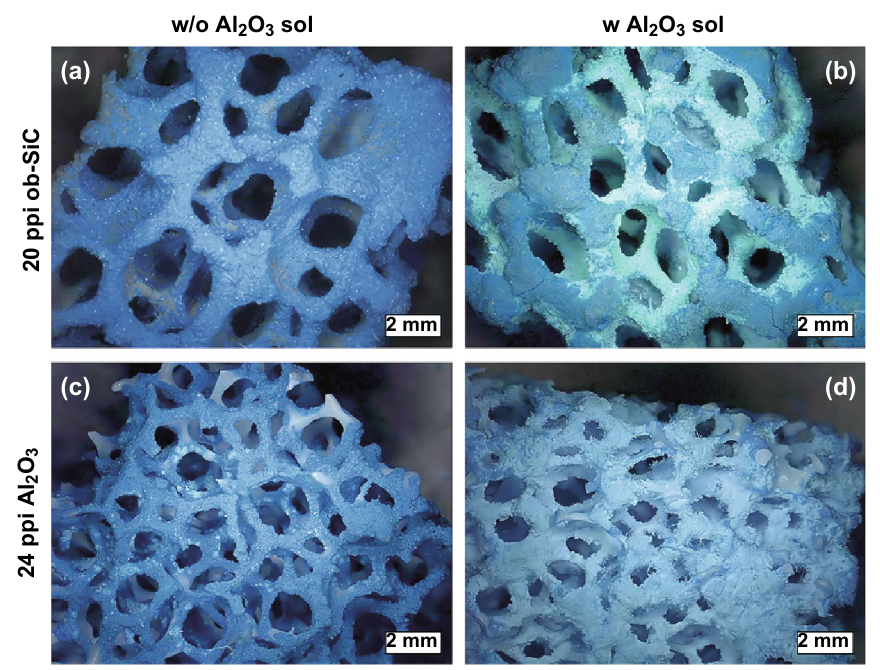
Fig. 3 SEM images of HKUST-1 coatings on ob-SiC and Al 2 O 3 ceramic foams a, c without and b, d with preliminary alumina sol coating. The HKUST-1 coating layers on the ob-SiC composites are thicker than those on Al 2 O 3 composites. Reprinted with permission from Ref. [63].